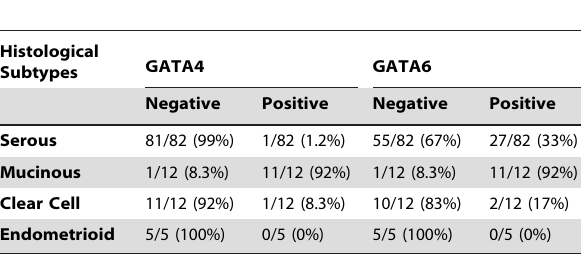
Table 1. Expression of GATA4 and GATA6 in ovarian cancer histological